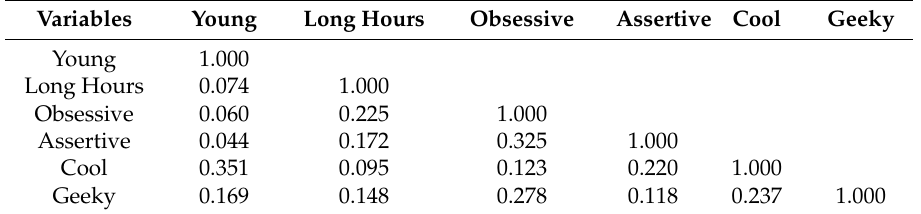
Table A3. Pearson’s Zero-Order Correlation Coefficients from Bivariate Pairs of Cultural Scale Traits Describing Self (Simard et al. 2007).